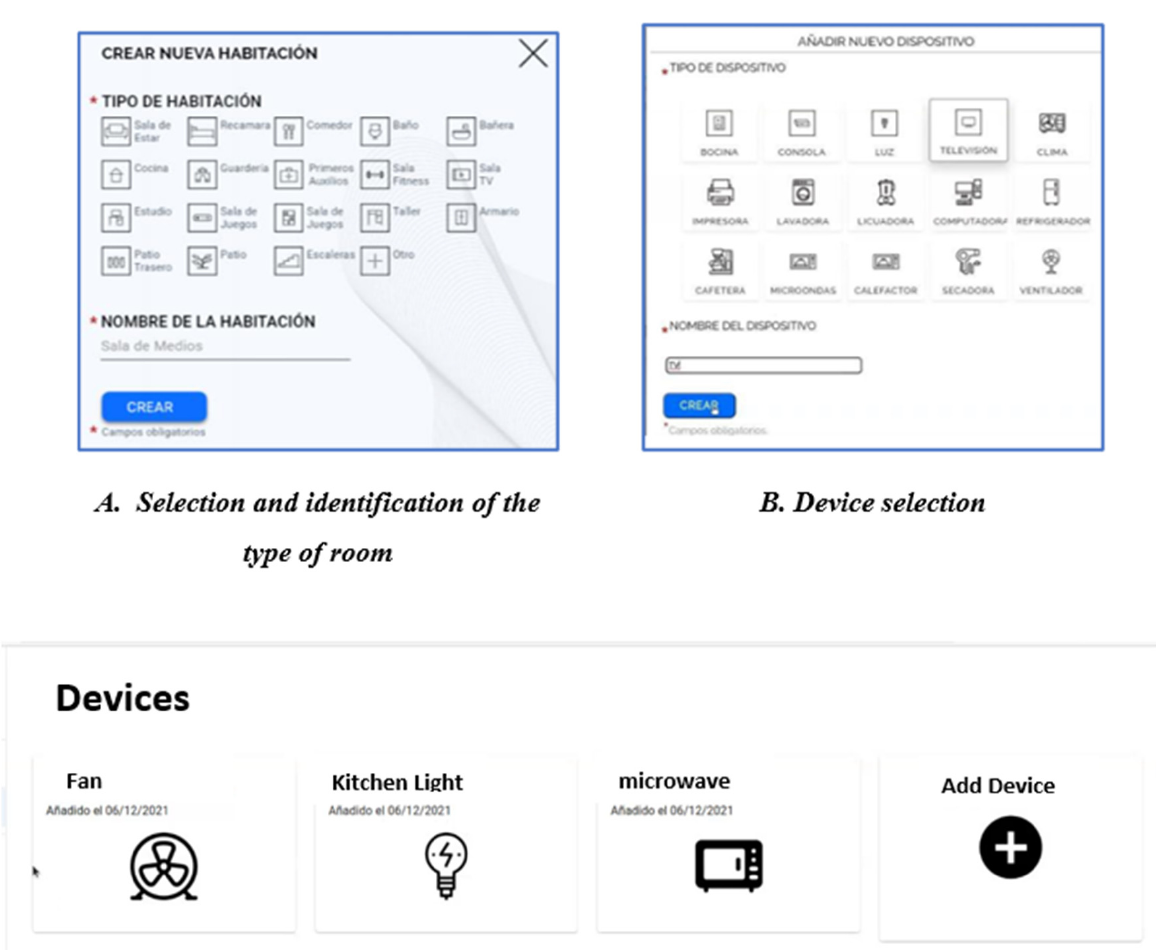
Figure 6. Interactive system to set the different real-life scenarios: ( A ) Users’ scenarios or rooms definition where the different devices could be added by using the ( B ) device selector interface.